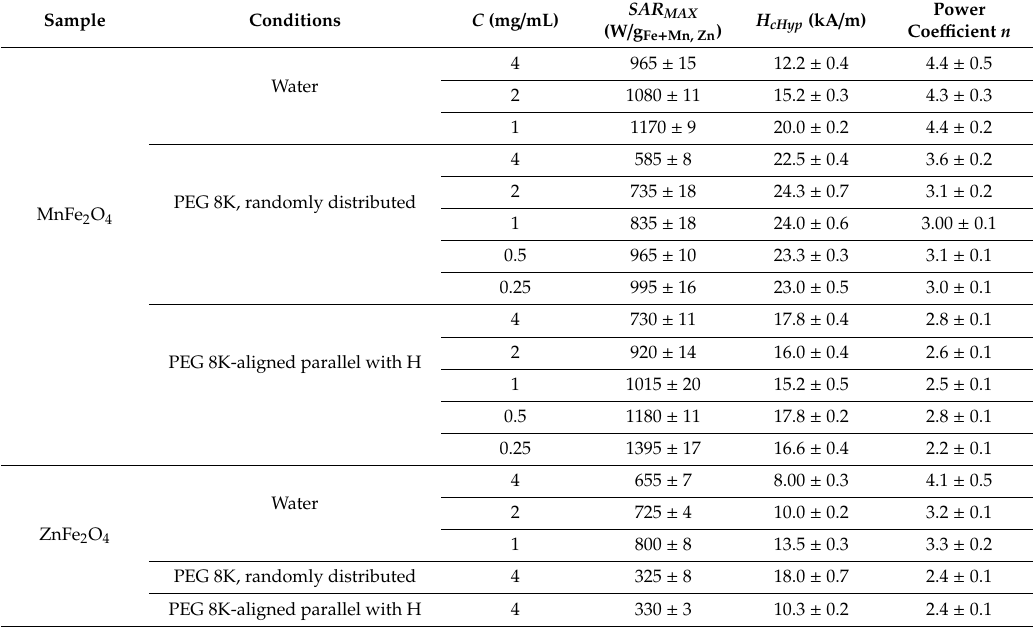
Table 2. Fitting results of SAR evolution with AMF magnetic field